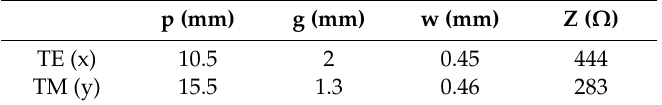
Table 2. Geometrical dimensions of the sectorial absorber B for each polarization.